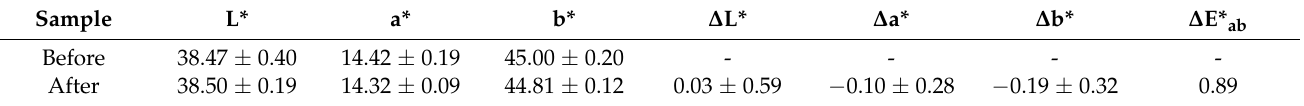
Table 4. Changes in color before and after fermentation of the R–B mixed juice with L. plantarum TUST-232. Sample L* a* b* ∆ L* ∆ a* ∆ b* ∆ E* ab Before 38.47 ± 0.40 14.42 ± 0.19 45.00 ± 0.20 - - - - After 38.50 ± 0.19 14.32 ± 0.09 44.81 ± 0.12 0.03 ± 0.59 − 0.10 ± 0.28 − 0.19 ± 0.32 0.89 ∆ E* ab , the change in color; L* (lightness); +L*, brighter; − L*, darker; a* (red/green component); +a*, redder; − a*, greener; b* (yellow/blue component); +b*, yellower; − b*, bluer. The error bars indicate means ± SD ( n = 3); the differences between groups were analyzed by a two-tailed paired Student’s t